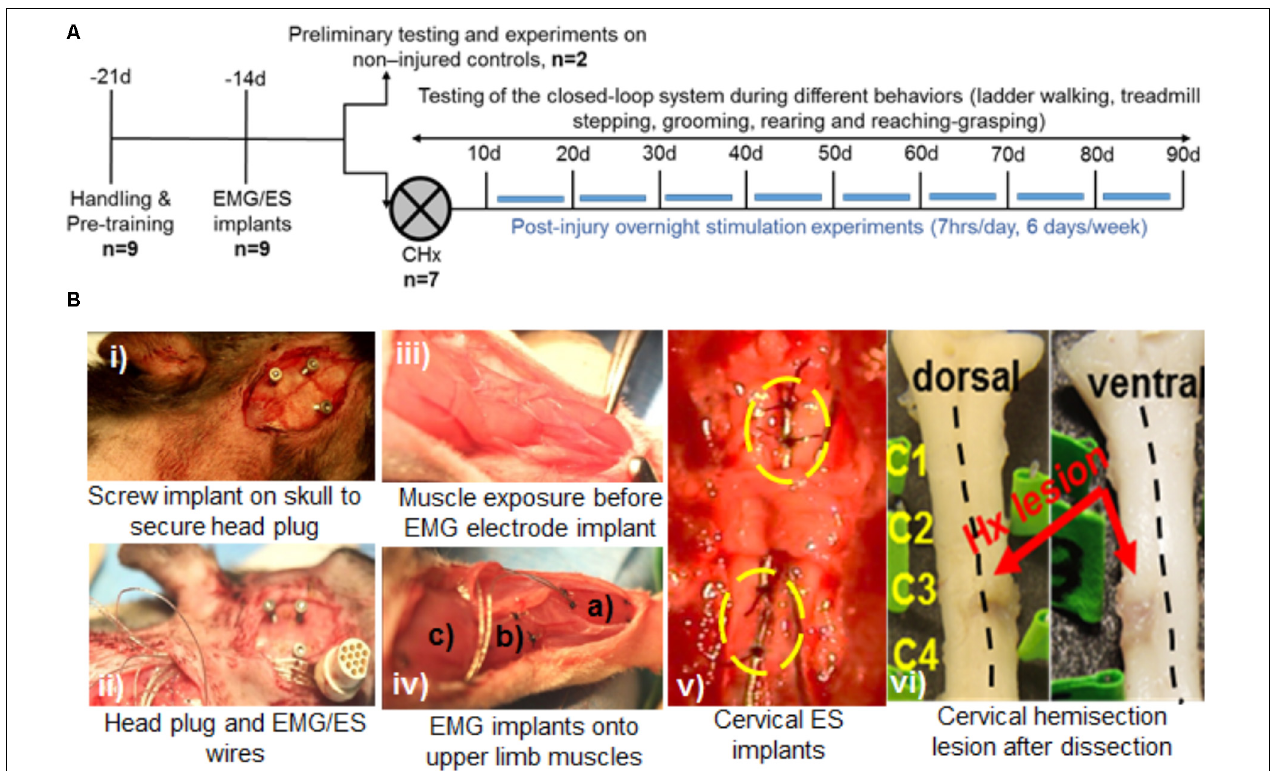
FIGURE 1 | Experimental outline, behavioral and surgical procedures. (A) Rats were initially handled prior to all experiments and trained for treadmill stepping and reaching-grasping activities. Later, rats underwent EMG and ES implants and were randomized into two experiments: Experiment I: two rats served as non-injured controls and were subjected to several pilot trials for initial testing of the closed-loop ES system in a variety of motor behaviors (open field walking, ladder walking, treadmill stepping, and grooming) and overnight stimulation experiments. Experiment II: seven rats received a cervical hemisection injury at the C4 spinal segment (CHx). They were trained with triggered ES (tES) during normal night cage activity for ∼ 7 h/day, 6 days/week for starting at 10 days after injury. Open field, ladder stepping, rearing, reaching-grasping and grooming tests were performed at multiple time points throughout the study. (B) Still photographs of EMG/ES implants and the CHx site. (i) Three screw implants on the skull were used to secure the head plug connector. (ii) EMG/ES electrode wires are routed subcutaneously underneath the neck region and routed toward the upper back. (iii) Exposure of forelimb muscles prior to EMG implantation. (iv) Select forelimb muscles [ (a) flexor digitorum (b) pronator (c) deltoid] are implanted with EMG electrodes. (v) Epidural implants are shown at C6 (upper circle) and C8 (lower circle) spinal segments with two suture knots (black knots within circles) to secure the implants. (vi) Gross dorsal and ventral views of the cervical spinal cord shows the CHx lesion site at C4 replaced